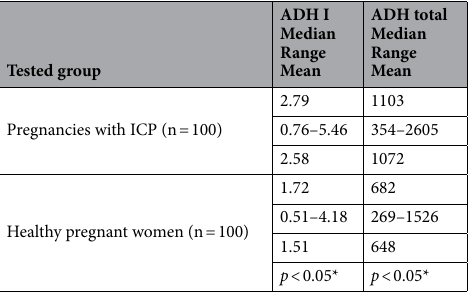
Table 2. Serum activity of ADH in ICP women and healthy pregnant. Data are expressed as mU/l. p , pregnancies with ICP versus healthy pregnant women. *Statistically significant differences between suitable groups.